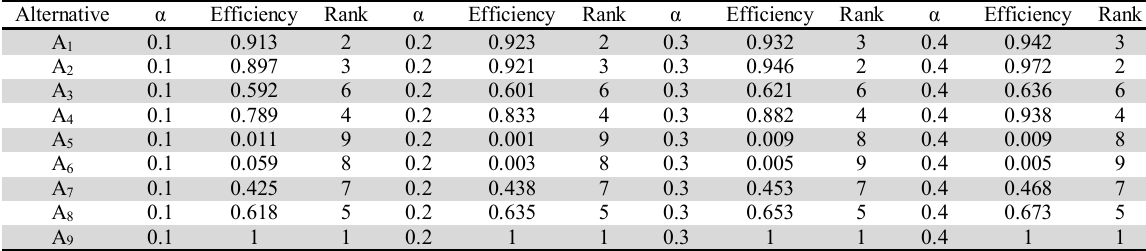
The summary of the results of fuzzy